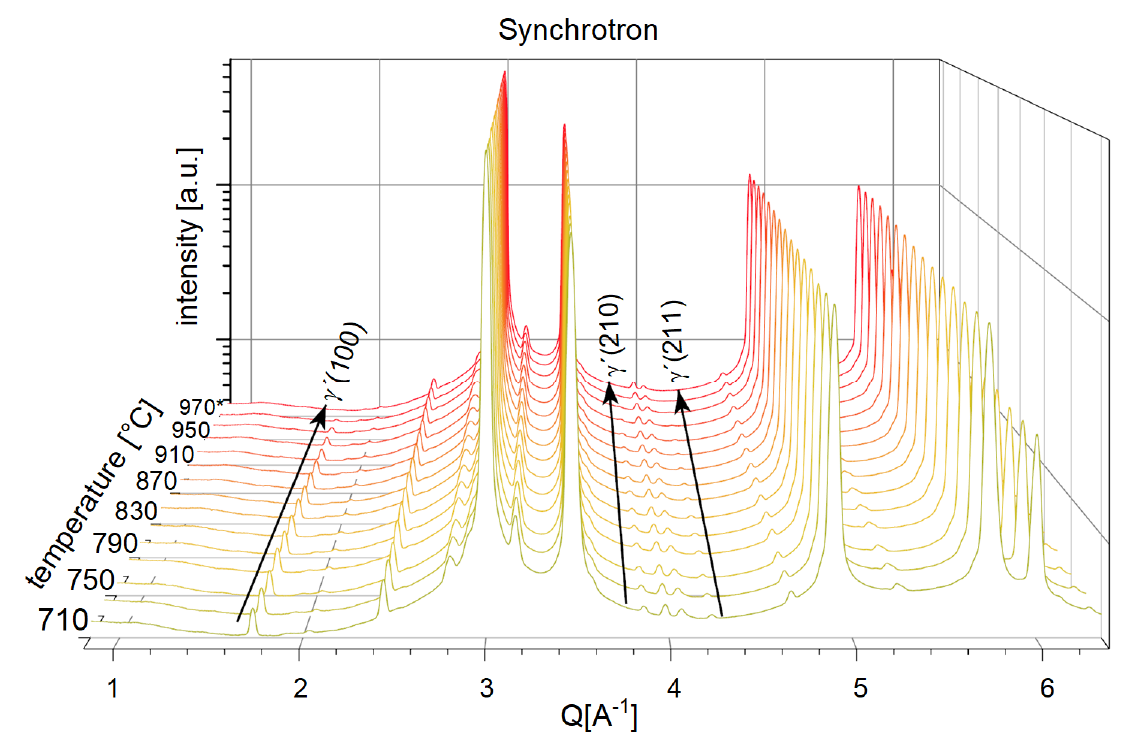
Figure 5. Synchrotron diffraction pattern of VDM Alloy 780 tested at different temperatures (710 °C to 970 °C).